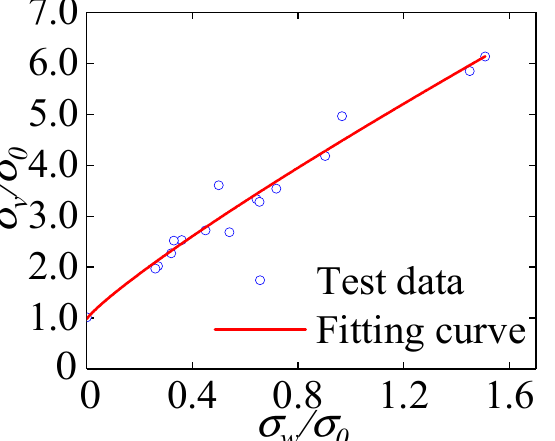
Figure 17. Relationship between peak stress and confining pressure value.